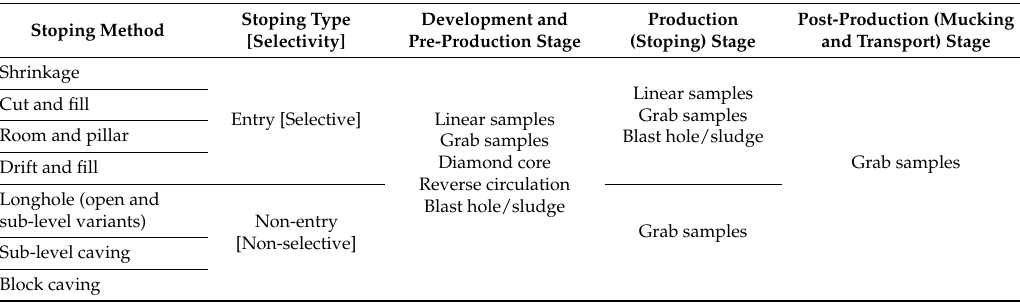
Table 7. Sample type for different stoping methods during the mining production chain.